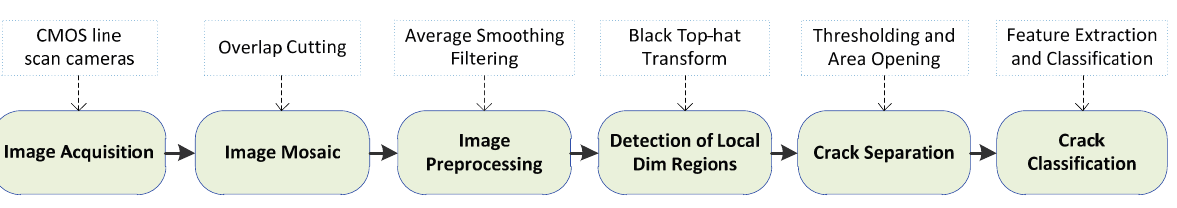
Figure 1. Flowchart of the proposed